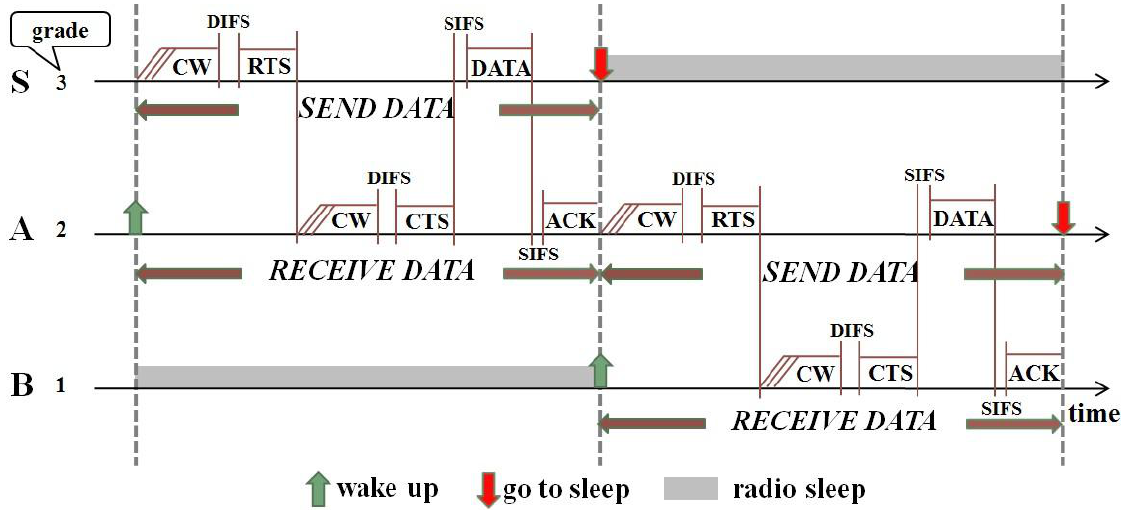
Figure 2. P-MAC integrated with routing. Node S has data to send to the